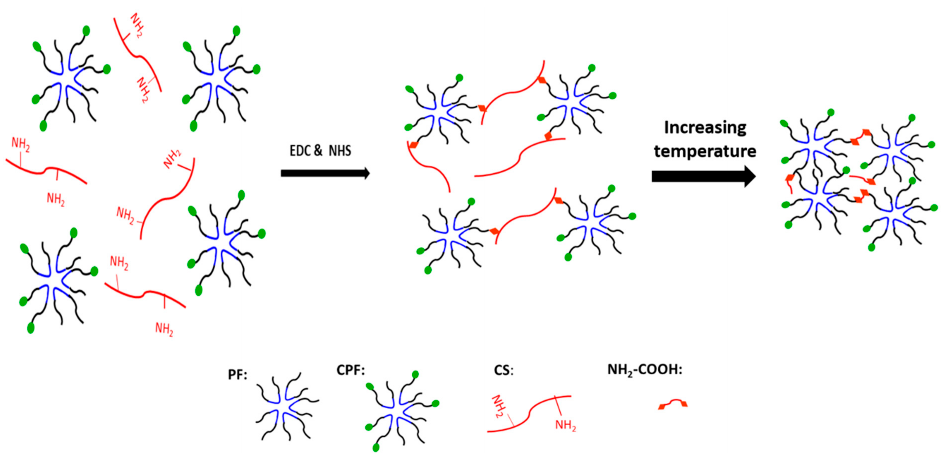
Figure 4. ( A ) FT-IR spectrum of (a) Au@OBC, (b) OBC, (c) BC, (d) PF, and (e) CPF. ( B ) UV-Vis absorption of aqueous suspensions of (a) unsupported AuNPs, (b) OBC, and (c) Au@OBC.